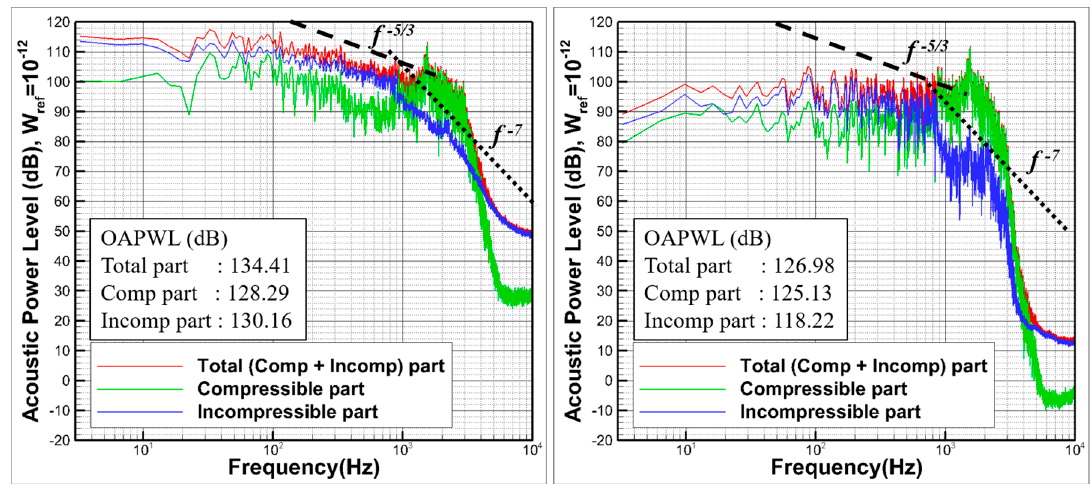
Figure 15. Overall acoustic power level (OAPWL); ( left ) Region 1, ( right ) Region 2.